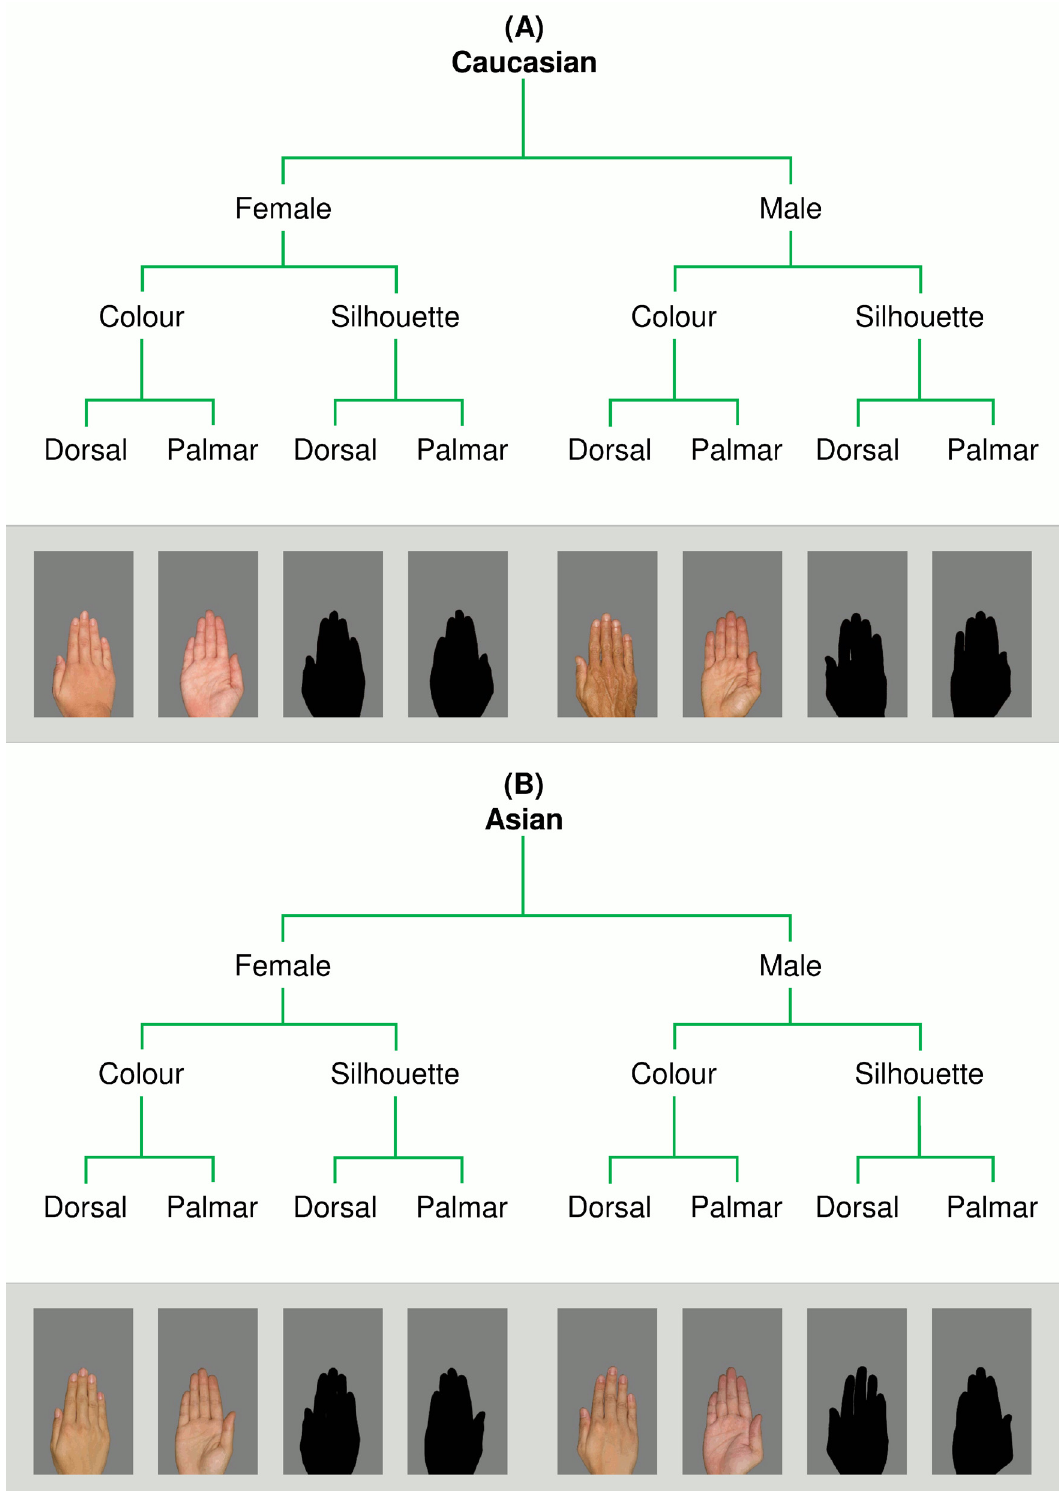
Fig 1. Stimulus exemplars used in the current study. ( A ) Caucasian and ( B ) Asian hand stimuli were reduced to the size of the smallest Caucasian exemplar without altering their natural aspect ratios. Within each stimulus condition 15 female and 15 male exemplars were represented.